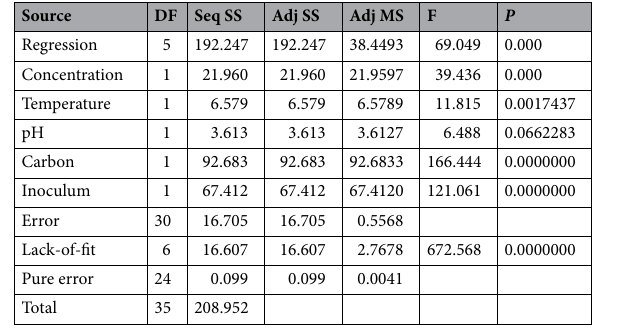
Table 2. ANOVA for PBD